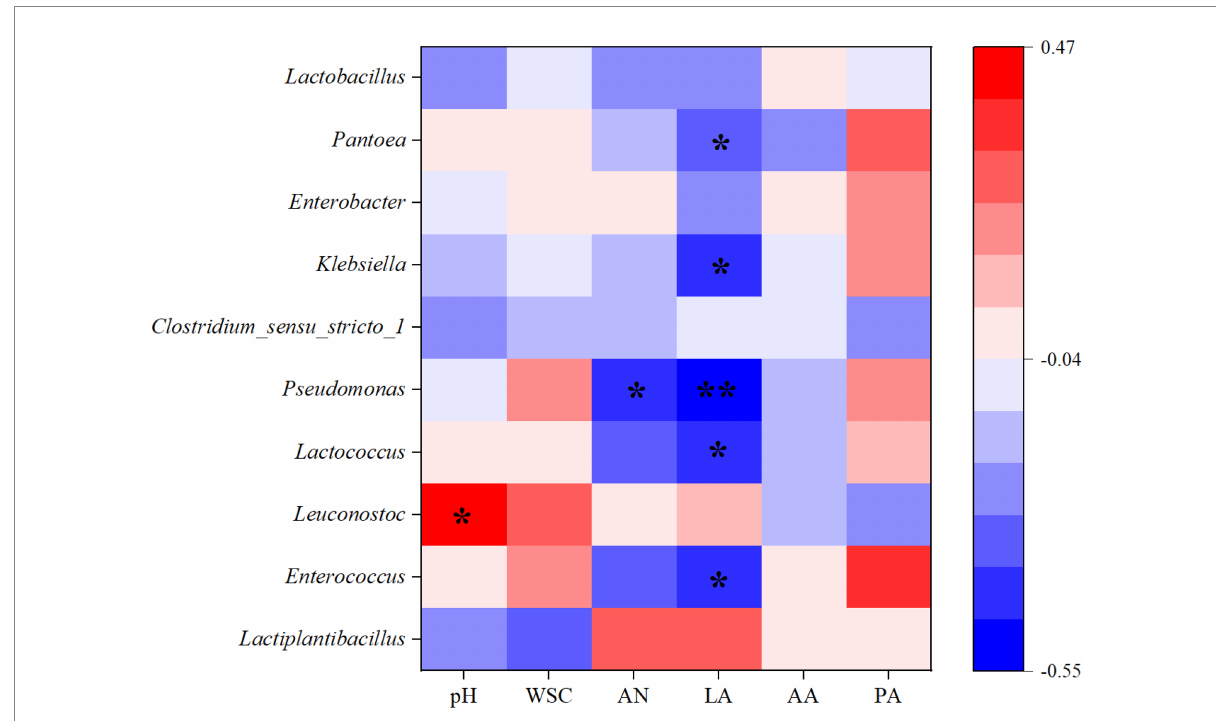
FIGURE 5 Heatmap of Spearman correlations between bacterial abundances and silage fermentation parameters on day 60. WSC, water-soluble carbohydrate; AN, ammonia nitrogen; LA, lactic acid; AA, acetic acid; PA, propionic acid. The colours in the heatmaps indicate the Spearman correlation coefficient r, which ranges from − 0.55 to 0.47. r < 0 indicates a negative correlation, and r > 0 indicates a positive correlation. ‘*’ and ‘**’ represent p < 0.05 and p < 0.01,